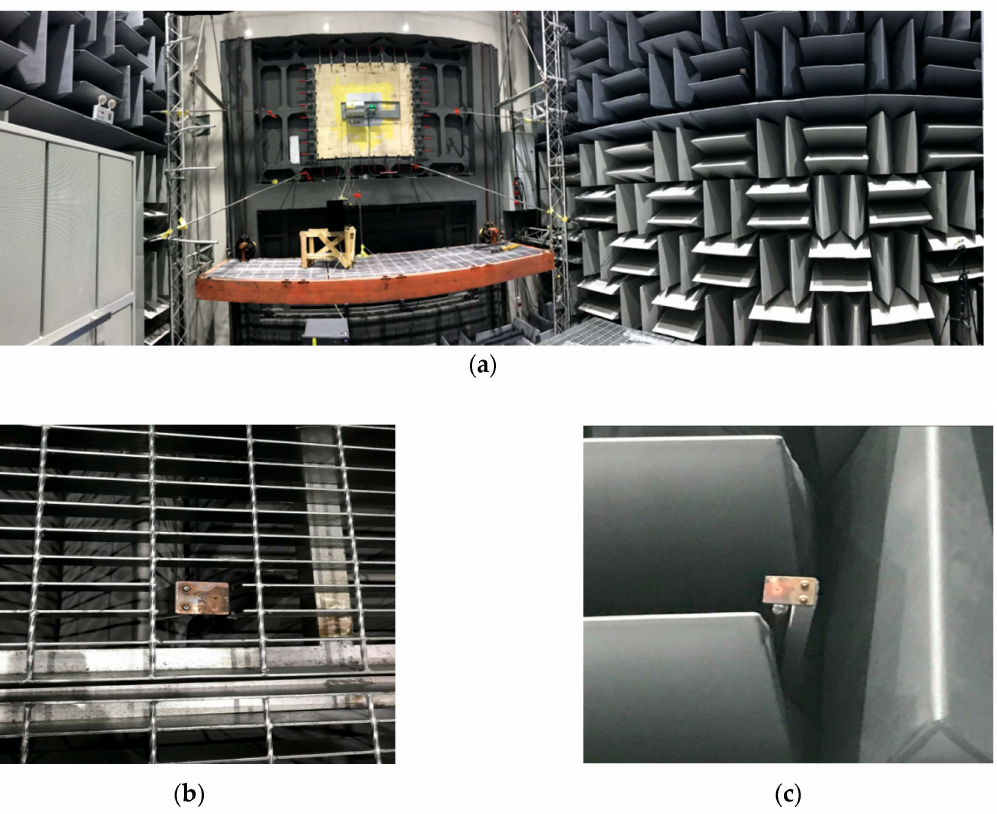
Figure 4. Air chambers. ( a ) The negative-pressure cavity of the soundproof chamber, ( b ) static- pressure sensor on the ground, and ( c ) static-pressure sensor on the